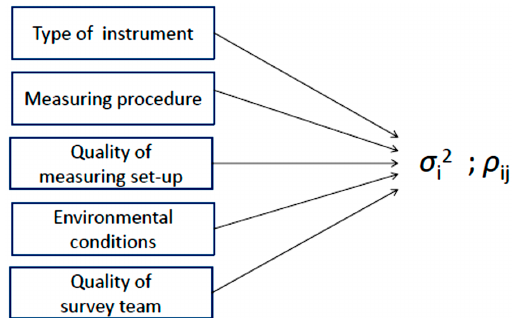
Figure 1. Set-up of a stochastic model within classical approach: external, instrumental and personal influences are considered “implicitly”, at least in a subjective way.